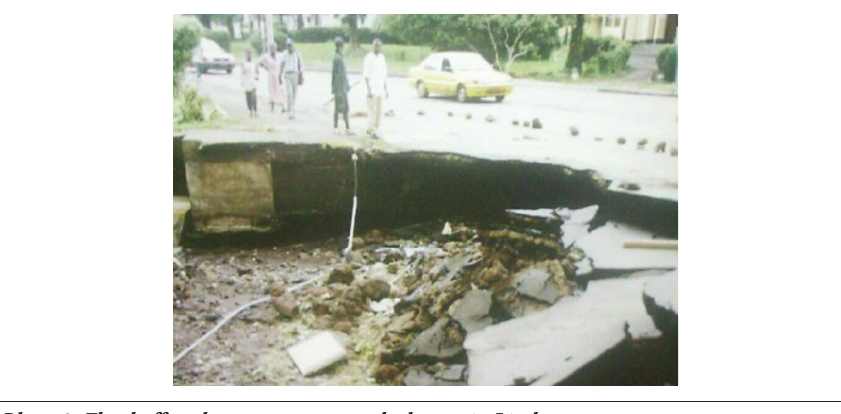
Photo 2: Flood-effect collapsed portion of tarred road in Limbe